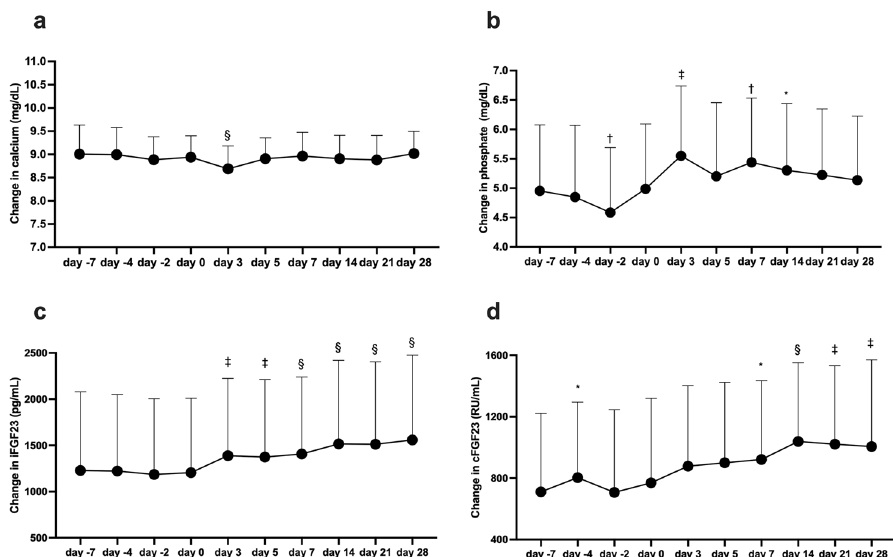
Figure 3. Changes in calcium, phosphate, and intact and C-terminal fibroblast growth factor 23 (FGF-23) levels. Changes in albumin-adjusted calcium ( a ), phosphate ( b ), and intact FGF23 (iFGF23) ( c ) and C-terminal FGF23 (cFGF-23) ( d ) levels after darbepoetin-α injection (at day − 7), and roxadustat supplementation (started from day 0). Data are shown as means ± standard deviation. Data during DA treatment are compared between the value at day − 7 and the target value, and data during roxadustat treatment are compared between the value at day 0 and the target value. *p < 0.05, † p < 0.01, ‡ p < 0.001, § p <